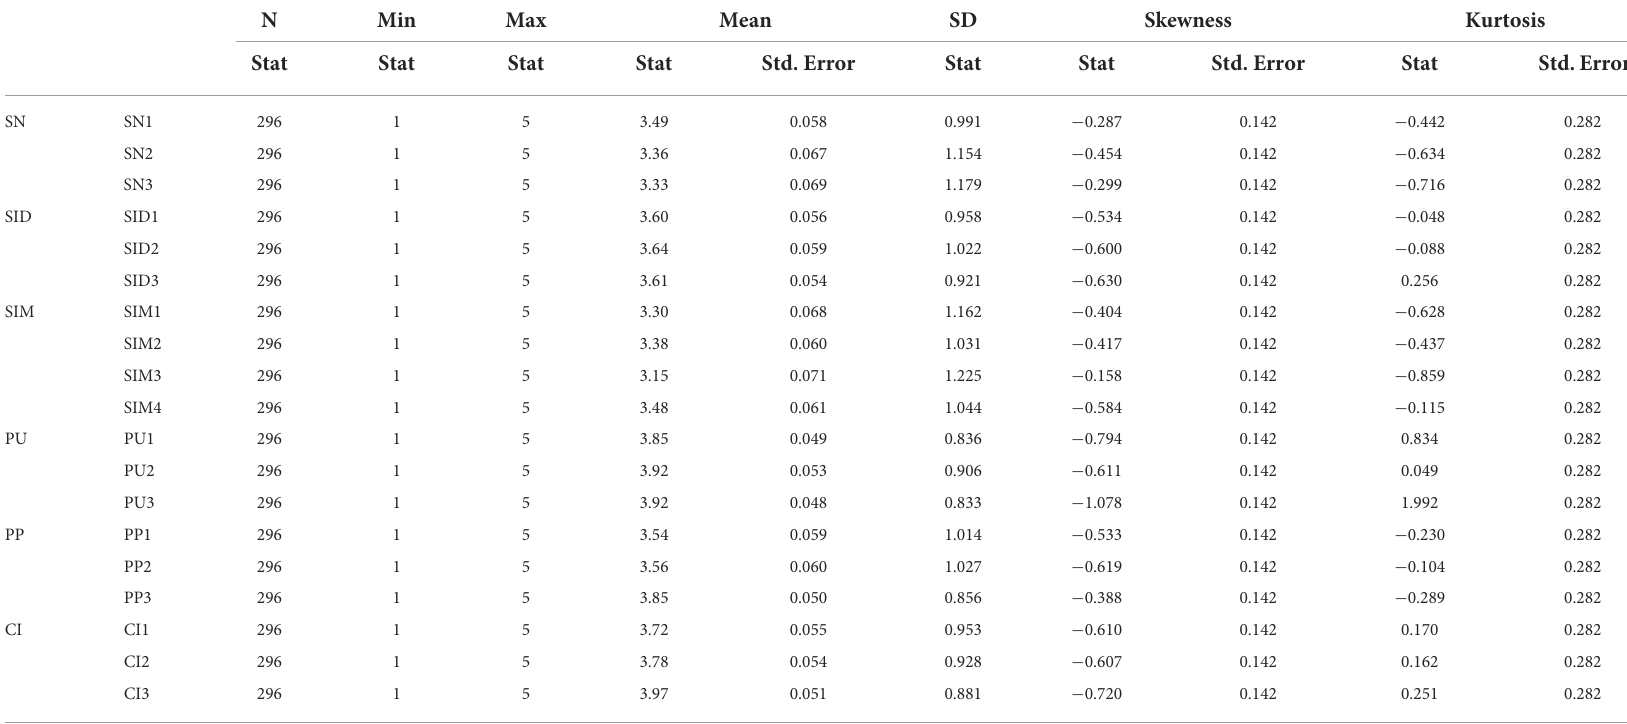
TABLE 3 Descriptive